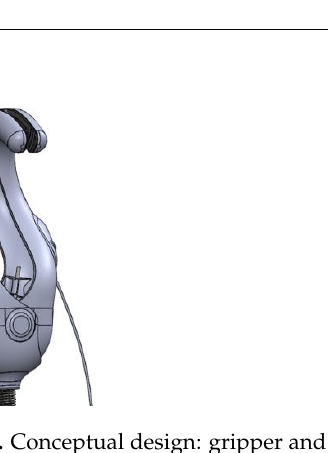
Figure 3. ( a ) Worm gear crown mechanism concept, ( b ) tubular band mechanism concept.